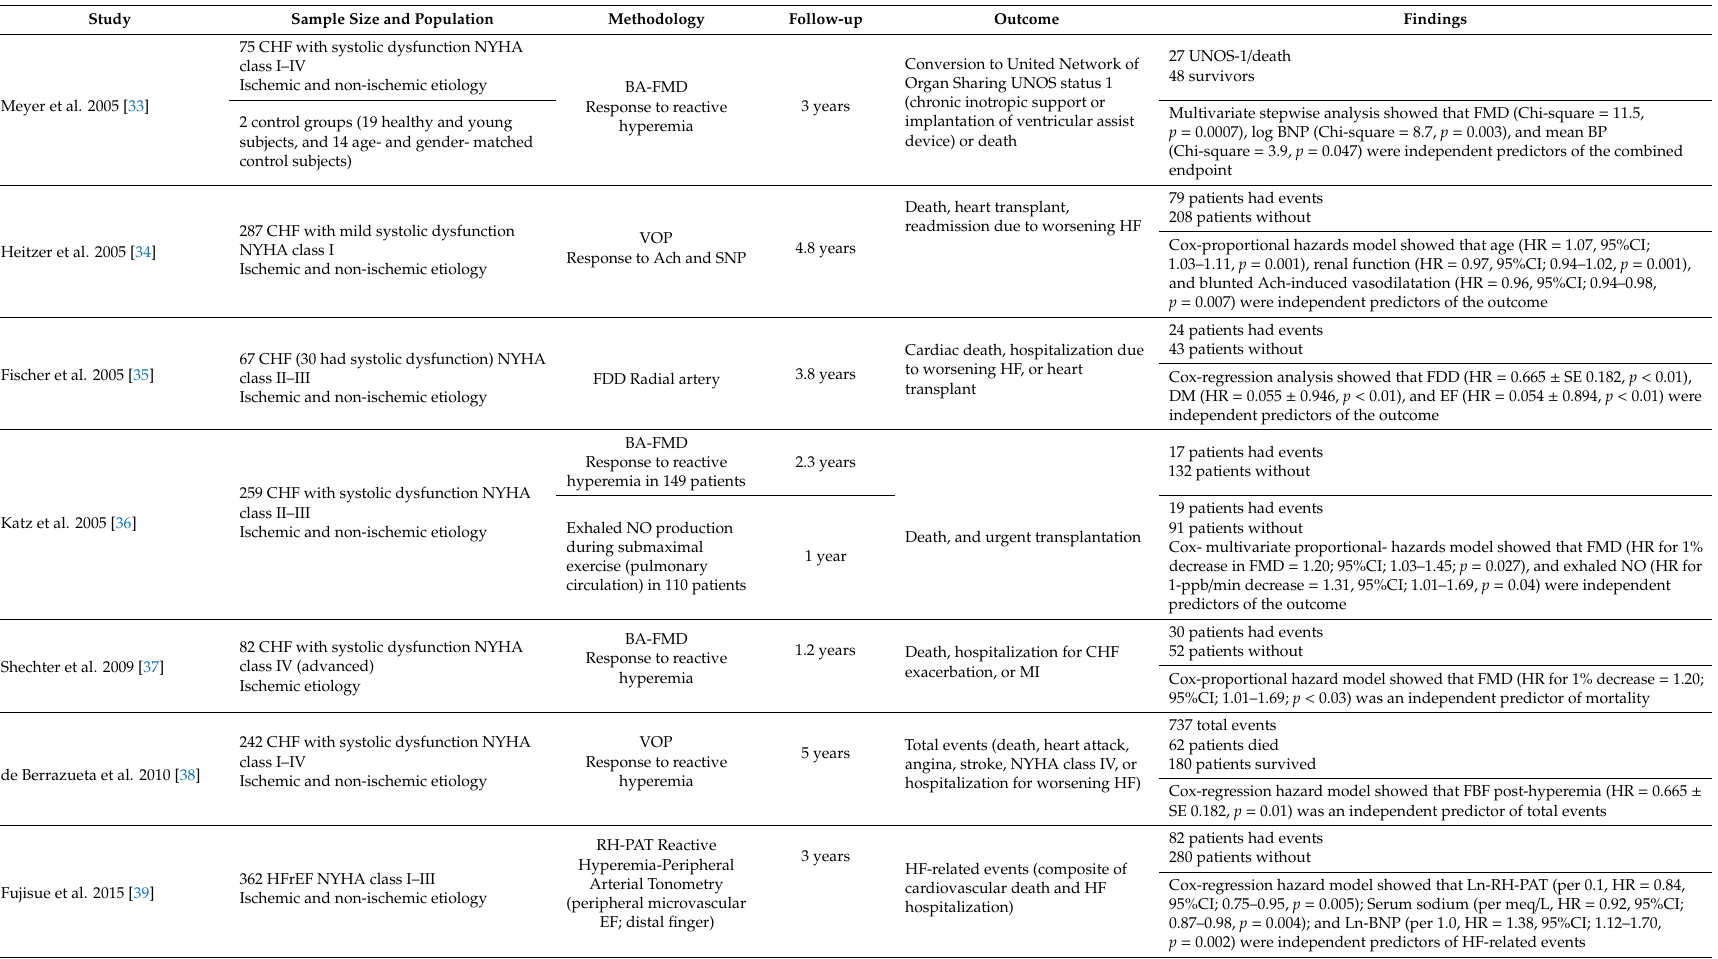
Table 2. Predictive value of endothelial dysfunction in HFrEF